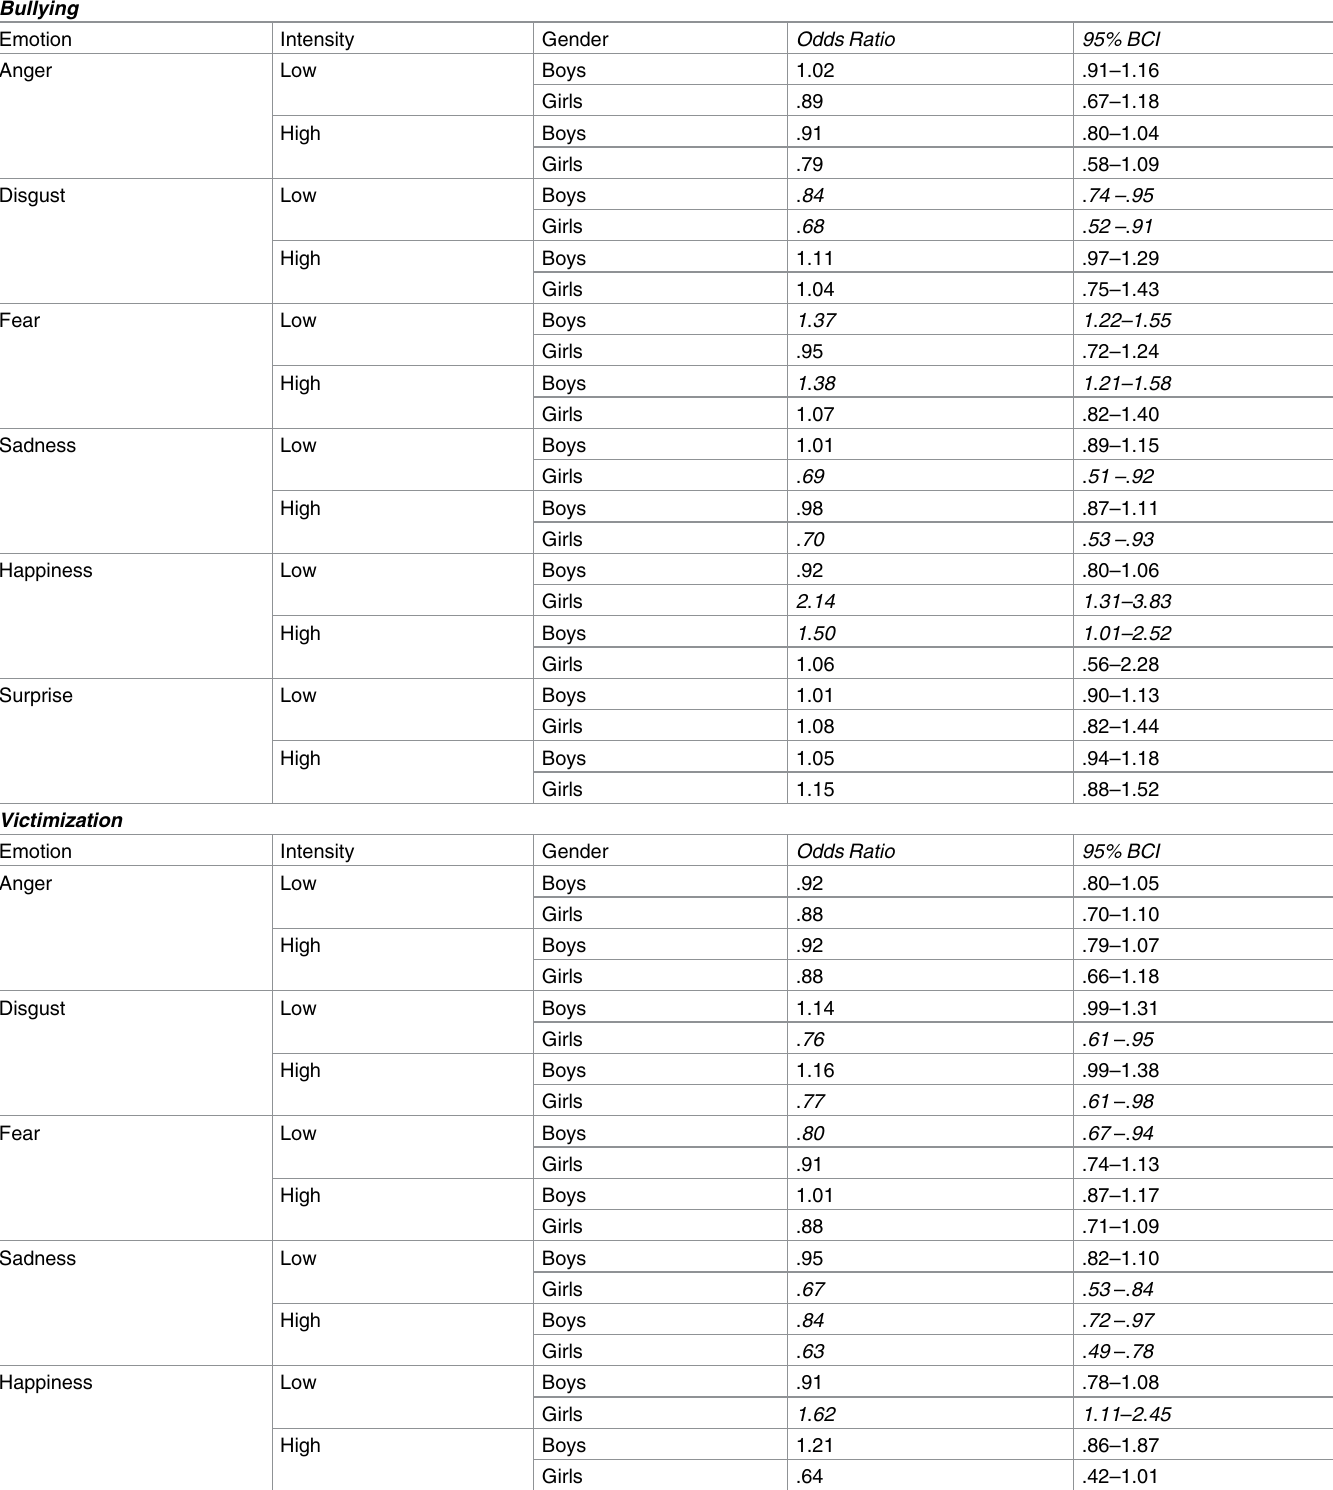
Table 8. Estimated Odds Ratios for emotion recognition associated with an increase of 10% in behaviors during bullying episodes (i.e., bullying/ /victimization/ defending/passive bystanding score) by type of behavior, emotion, intensity and gender.